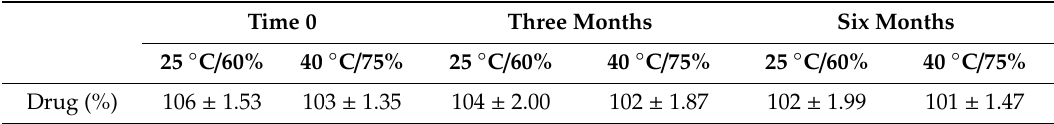
Table 7. Results of six-month stability of drug content (%) at two di ff erent temperatures and relative